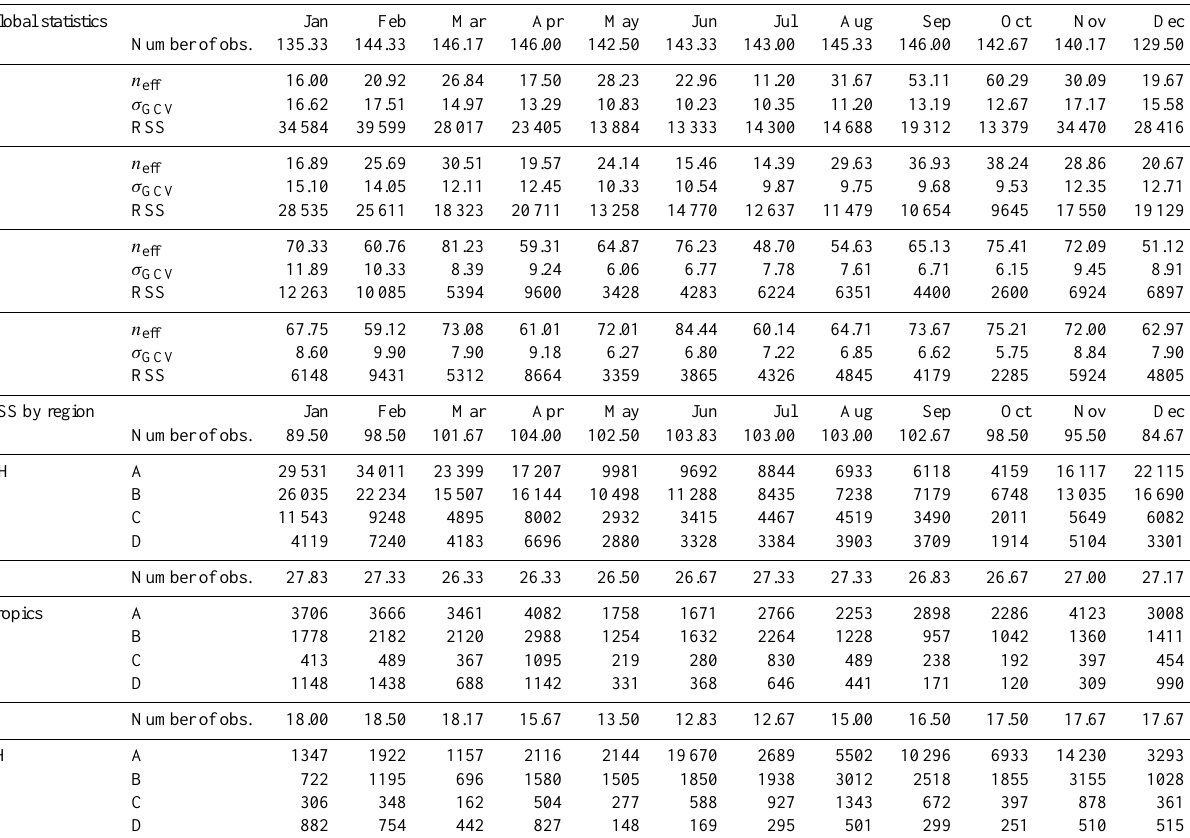
Table 2. Comparison of the generalized cross-validation error ( σ GCV ) and the residual sum of square (RSS) for different strategies averaged of 2000–2005 by month. Statistical summaries for Northern Hemisphere (NH), tropics and Southern Hemisphere (SH). Global